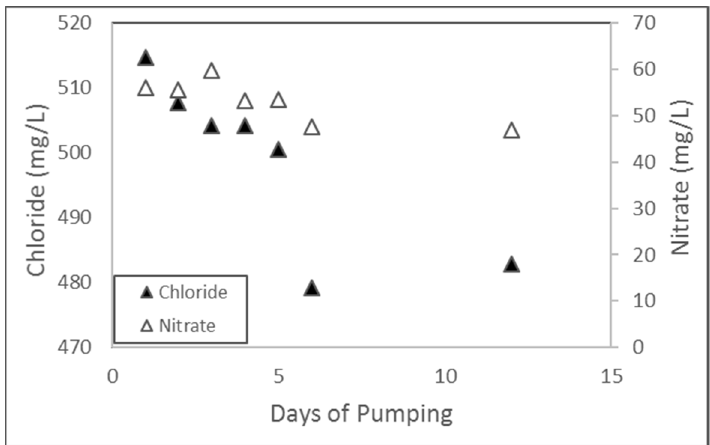
Figure 5. Chloride and nitrate concentrations decreased during continuous pumping of RBF2 well at Village 4.